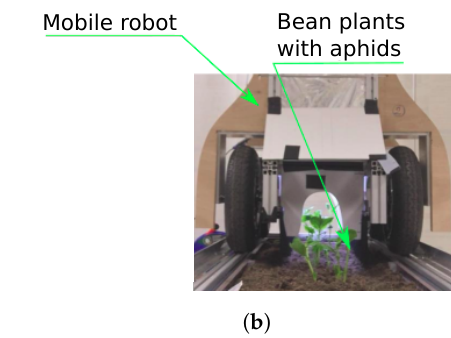
Figure 8. Detection Experimental Setup. ( a ) A picture acquired by the camera of the mobile robot; only the area contained in the blue frame is analyzed. The blue squares indicate the location of the detected aphids; ( b ) The robot spanning a row of broad bean plants featuring aphids (front